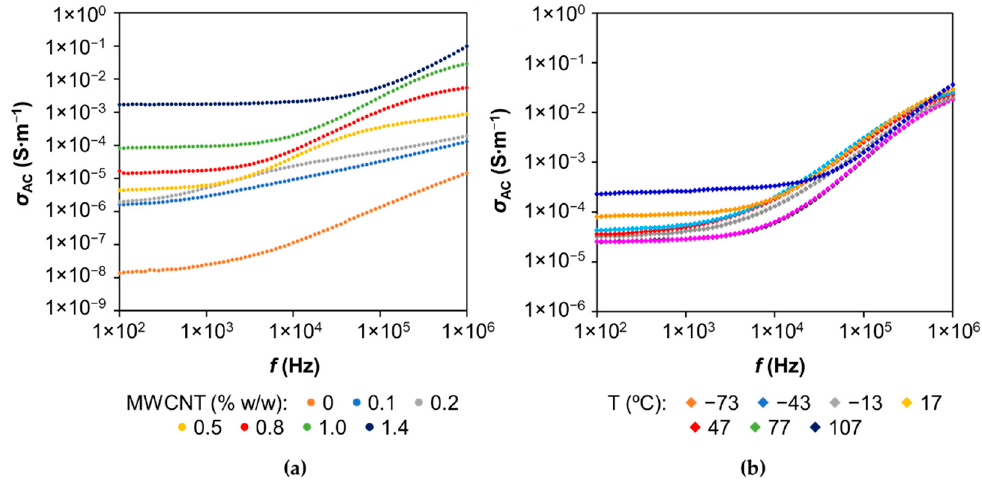
Figure 6. Frequency dependence of AC electrical conductivity, σ AC , for LS-based PU polymer doped with different amounts of MWCNT at 77 °C ( a ) and with 1% ( w / w ) MWCNT at different tempera- tures ( b ).